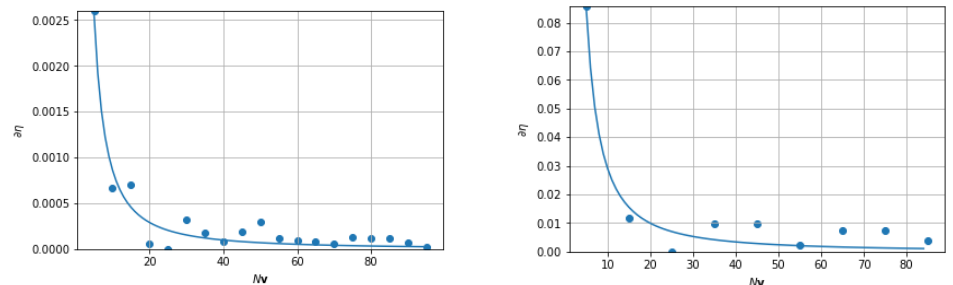
Figure 11. ( left ) Absolute value of Equation (23) for the ( top right ) DSM data in Figure 4: the closer ∂η is to zero, the better the quality (convergence) of the image. The solid blue line is a power law nonlinear regression for the measured data and shows the likely value of the quality metric as a continuous function of N v . ( right ) The same quantity plotted for the ( bottom right ) DSM data in Figure 4.